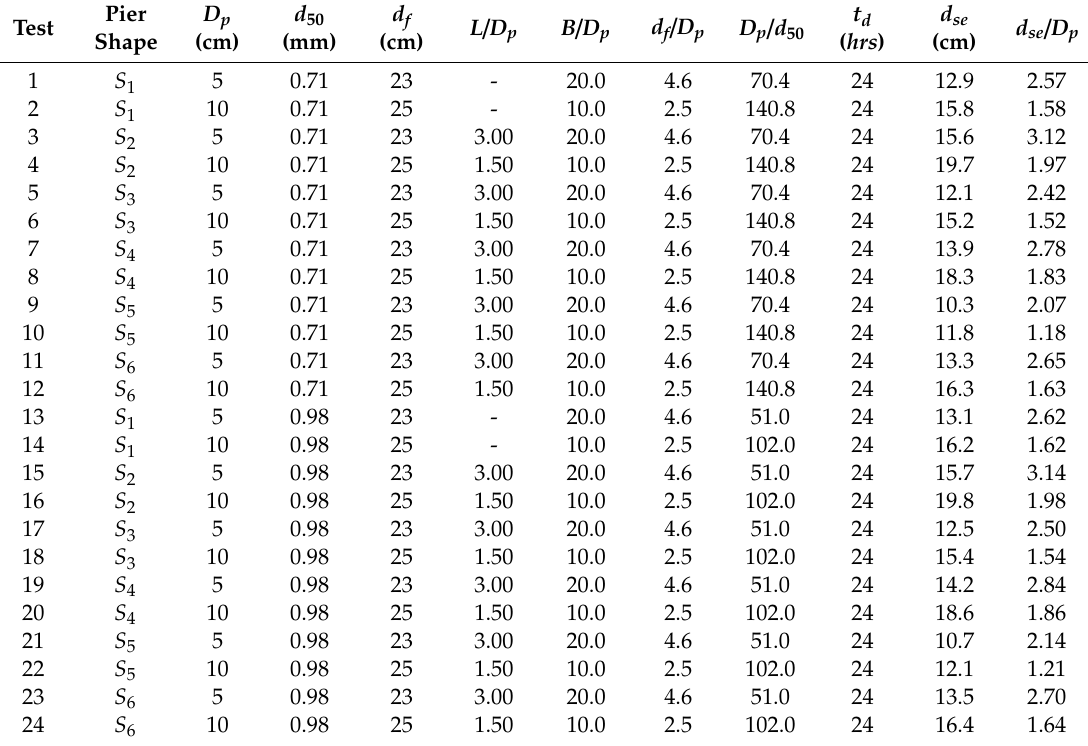
Table 3. Characteristic control variables and non-dimensional parameters of